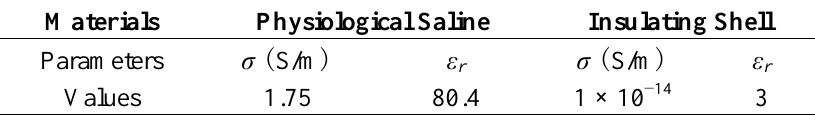
Table 1. The conductivity and relative permittivity of the materials. Materials